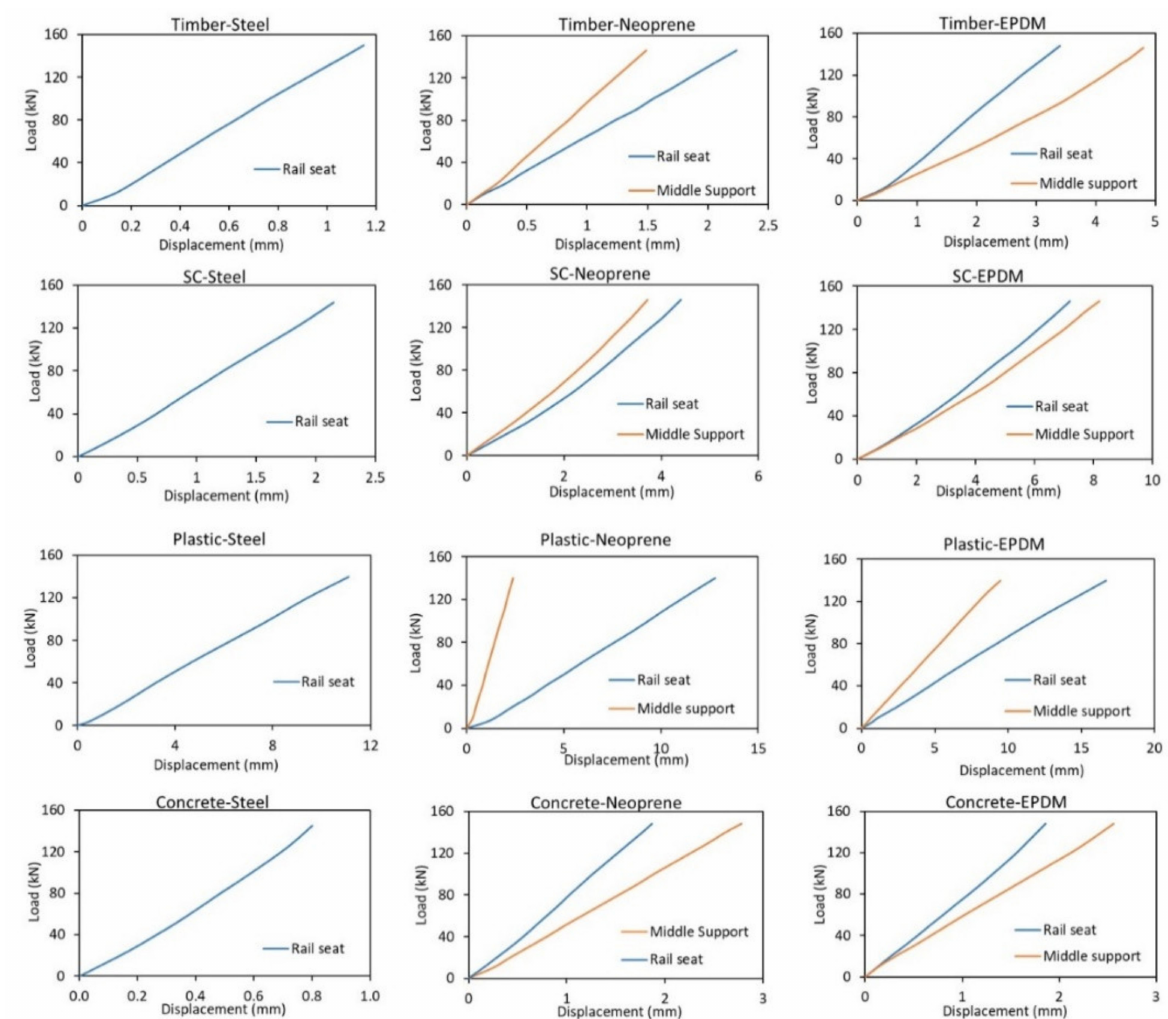
Figure 9. Load–displacement graphs measured at rail seat and